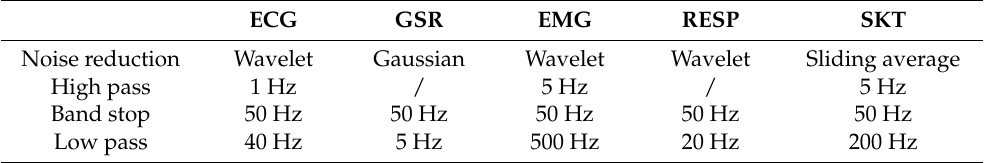
Table 2. Detailed data processing.